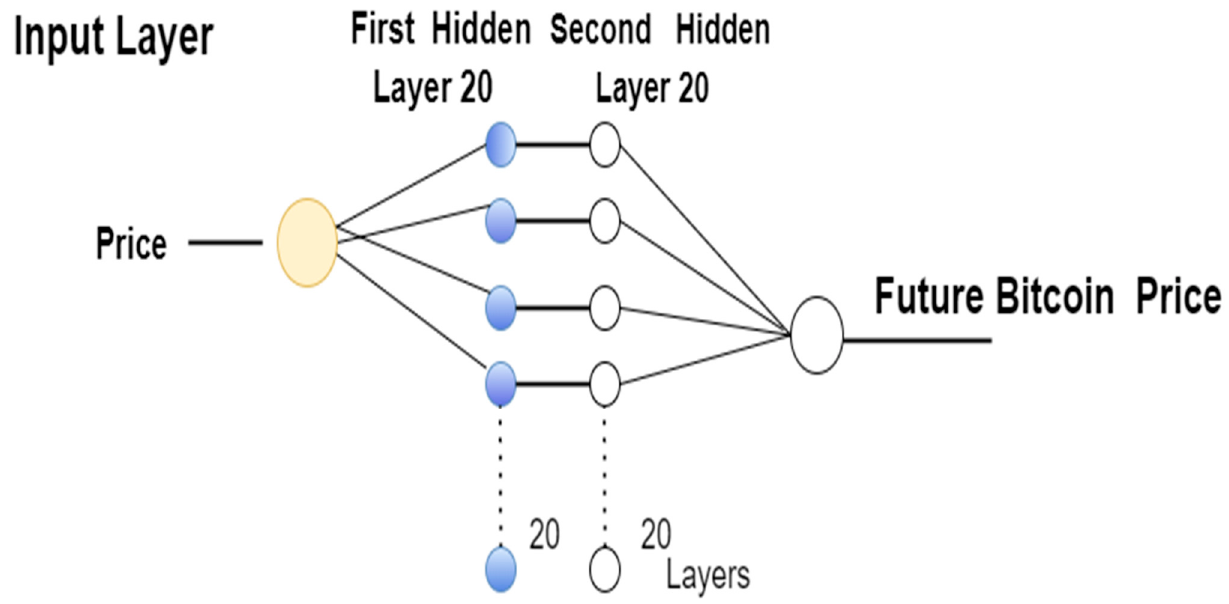
9 of 19 Table 1. Parameters of the developed MLP model. First hidden layer